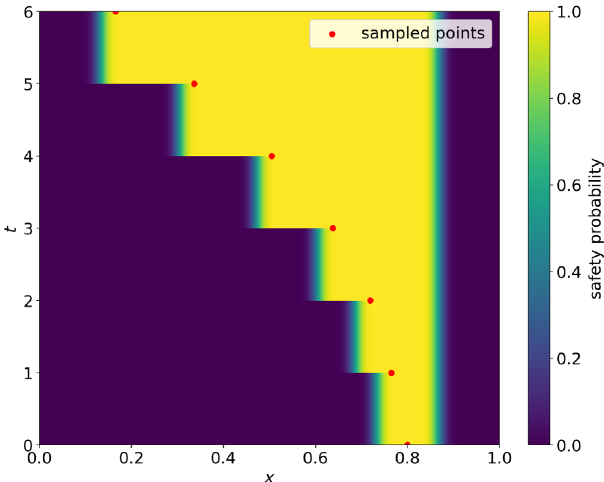
FIG. 2. Evolution of the safety probability during a safety exploration on the 1D test problem. The red dot denotes the time and position of the corresponding sampled